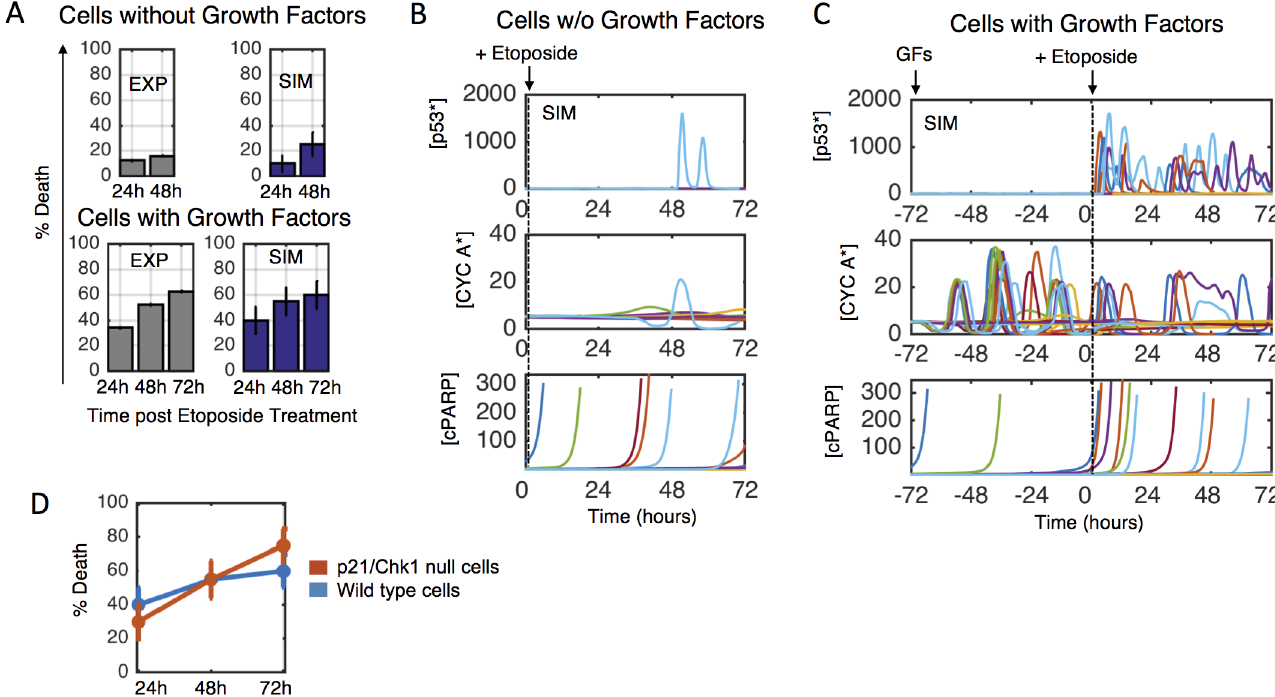
Fig 4. Etoposide response dynamics in dividing and non-dividing cells. A) Experiments (left, grey, flow cytometry) and simulations (right, blue) for MCF10A cells treated with etoposide (100μM) for 24, 48, and 72 hours in the presence of no growth factors (top) or EGF (20ng/mL) + insulin (10μg/mL) (bottom). B-C) Stochastic simulations for (B) serum-starved or (C) EGF + insulin with 72 hour etoposide treatment. D) Quantification of simulation results from (C) for wild type (blue) or p21/Chk1 loss cells (red).